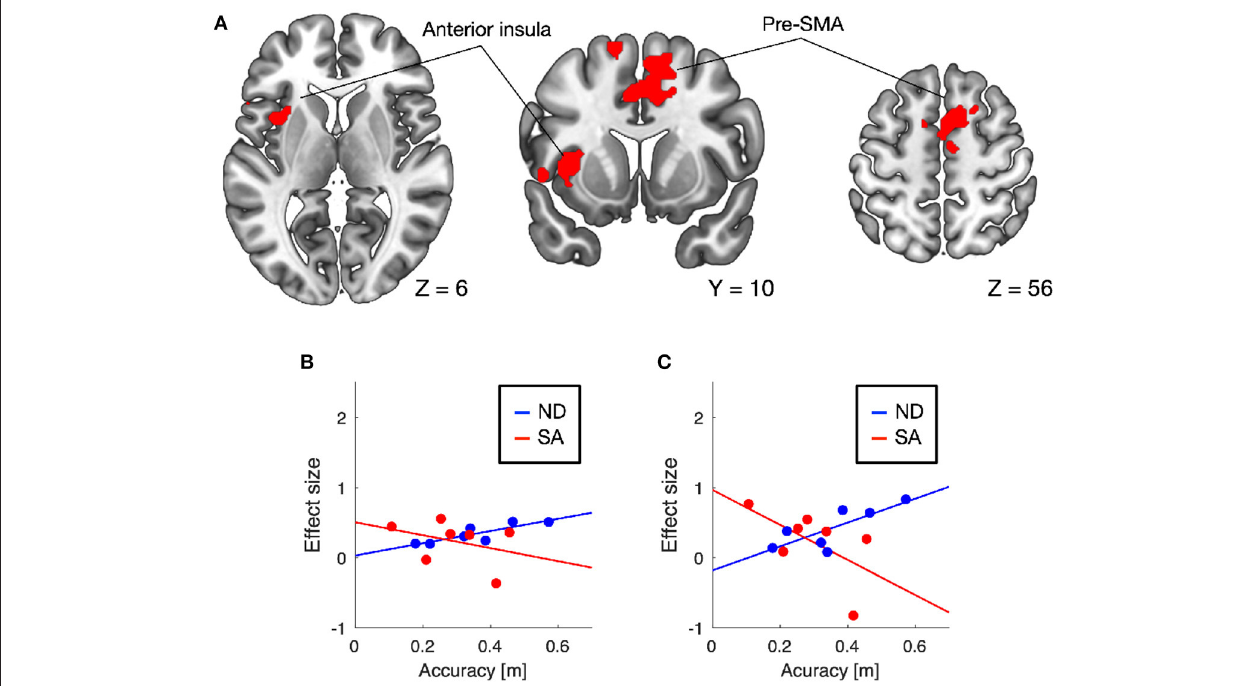
FIGURE 3 | Brain regions showing increased auditory responses after lane-keeping training under ND condition (pretest < posttest). Significant clusters (family-wise error (FWE) corrected P < 0.01) were found in the pre-supplementary motor area (pre-SMA) and left anterior insula (A) . In both clusters, increased activation after the training was positively correlated with lane-keeping accuracy under ND condition, but negatively under SA condition ( B , pre-SMA; C , anterior